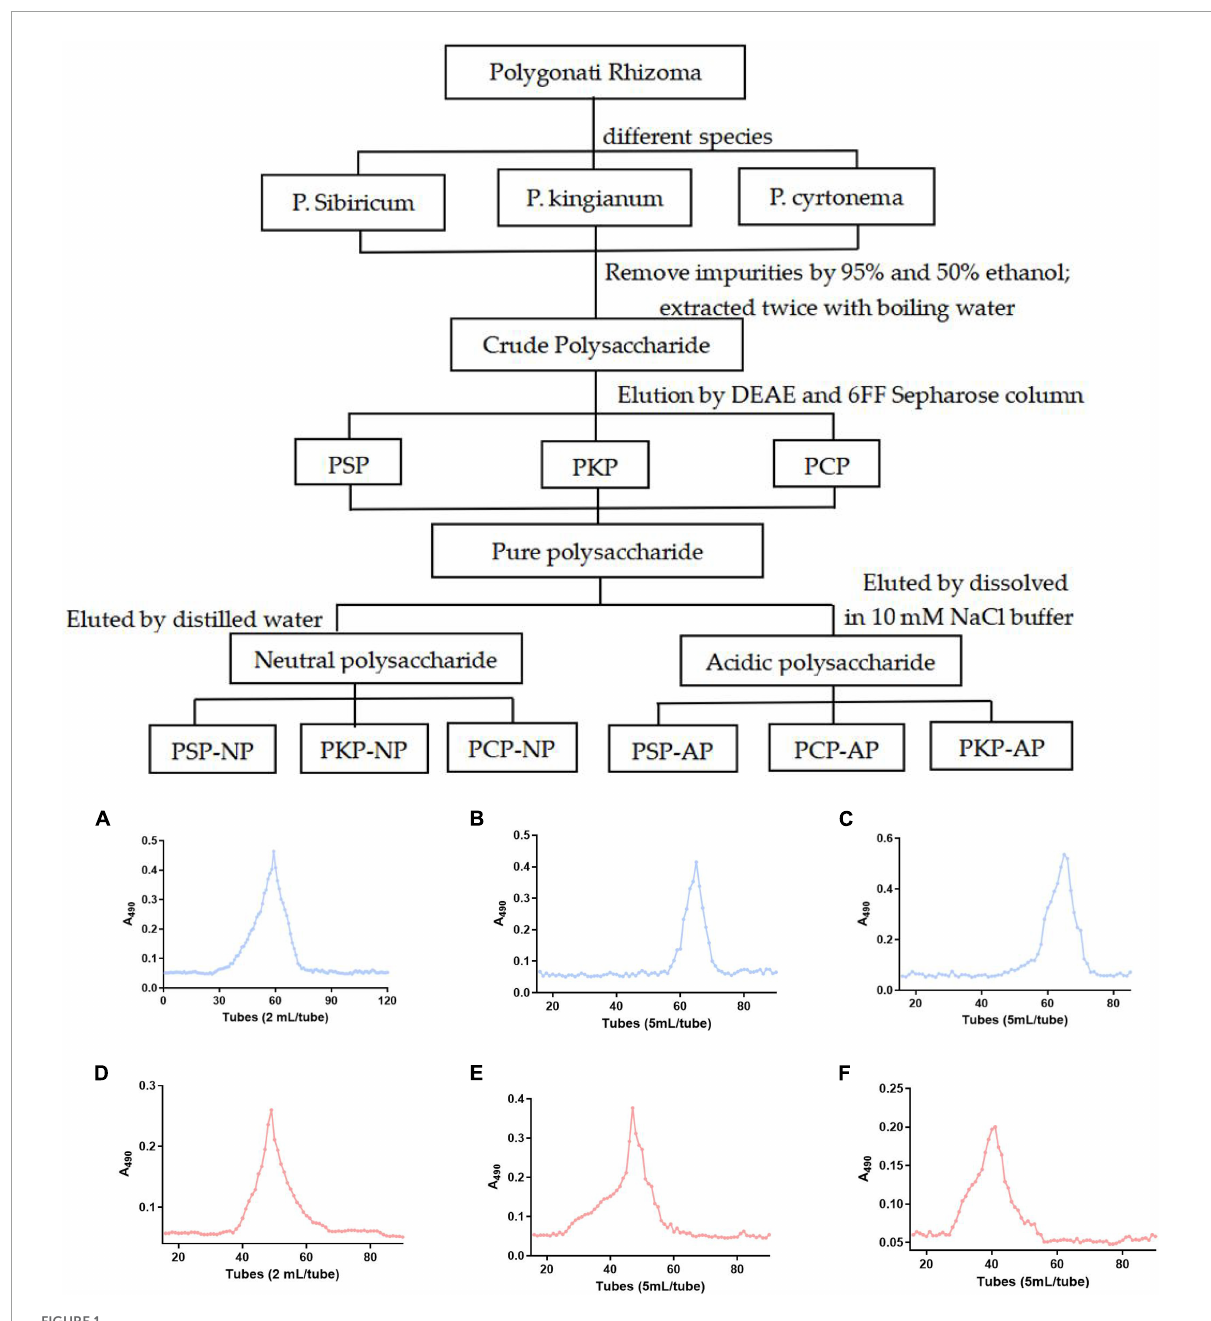
FIGURE1 Technical roadmap for extraction and purification of Polygonatum Polysaccharide from different varieties and elution profiles of polysaccharides in gel column. (A) PSP-NP, (B) PCP-NP, (C) PKP-NP, (D) PSP- AP, (E) PCP-AP, (F) PKP-AP.